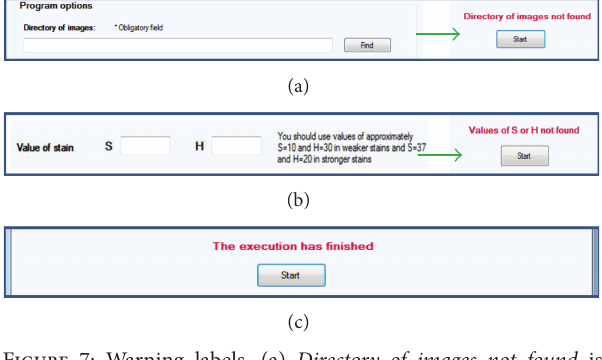
Figure 7: Warning labels. (a) Directory of images not found is displayed when the Start option is selected and the directory of images has not been previously selected. (b) Values of S or H not found is displayed when the Other option of stain is selected but the threshold values for S or H have not been set and (c) the execution has finished is displayed when all the images have been